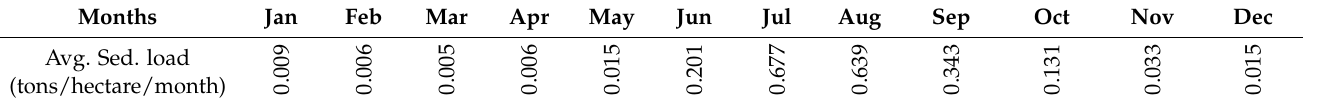
Table 9. Average monthly variation of sediment